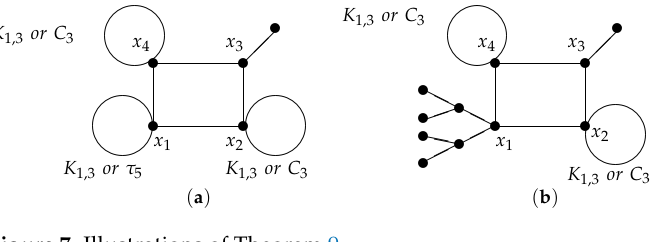
Figure 7. Illustrations of Theorem